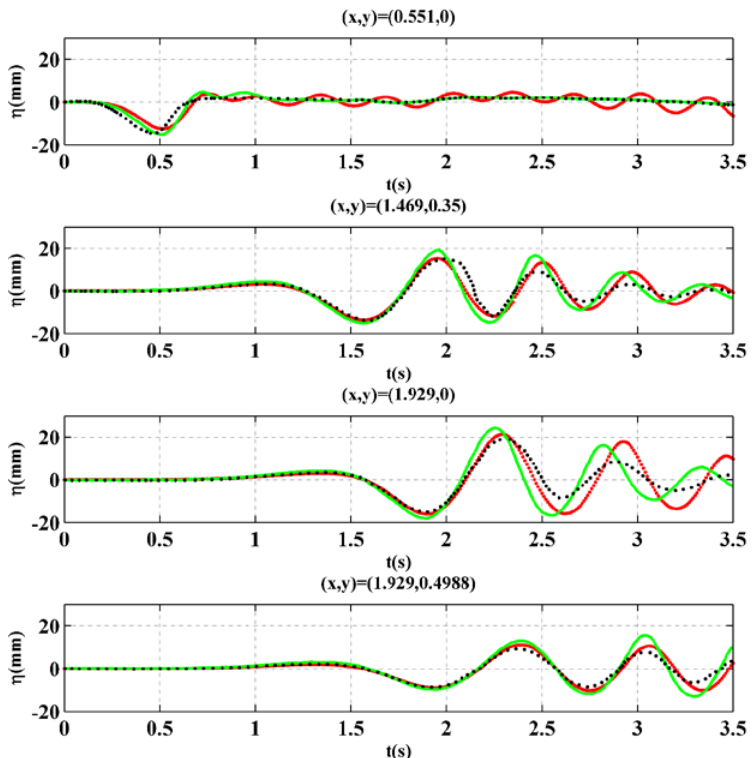
Figure 10. Comparison of present results (red line) with experimental data [6] (black dots) and the results in Fuhrman and Madsen [10] (green line) in case 1.